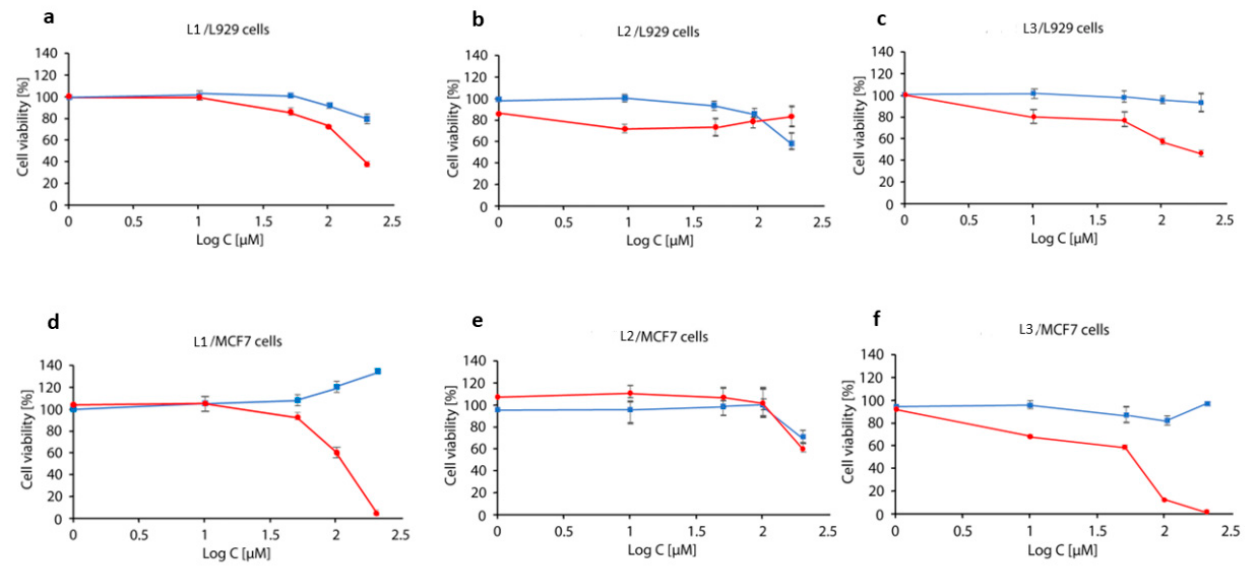
Figure 7. Cytotoxic activity of the investigated complexes (red line) and the ligands (blue line) against breast cancer cells MCF7 vs. mouse fibroblast cell line L929 (in corresponding concentrations): ( a ) mouse fibroblast cell line L929 for L1 and Cu(L1) 2 Cl 2 ; ( b ) mouse fibroblast cell line L929 for L2 and Cu(L2)Cl 2 ; ( c ) mouse fibroblast cell line L929 for L3 and Cu(L3)Cl 2 ; ( d ) breast cancer cells MCF7 for L1 and Cu(L1) 2 Cl 2 ; ( e ) breast cancer cells MCF7 for L2 and Cu(L2)Cl 2 ; ( f ) breast cancer cells MCF7 for L3 and Cu(L3)Cl 2 .